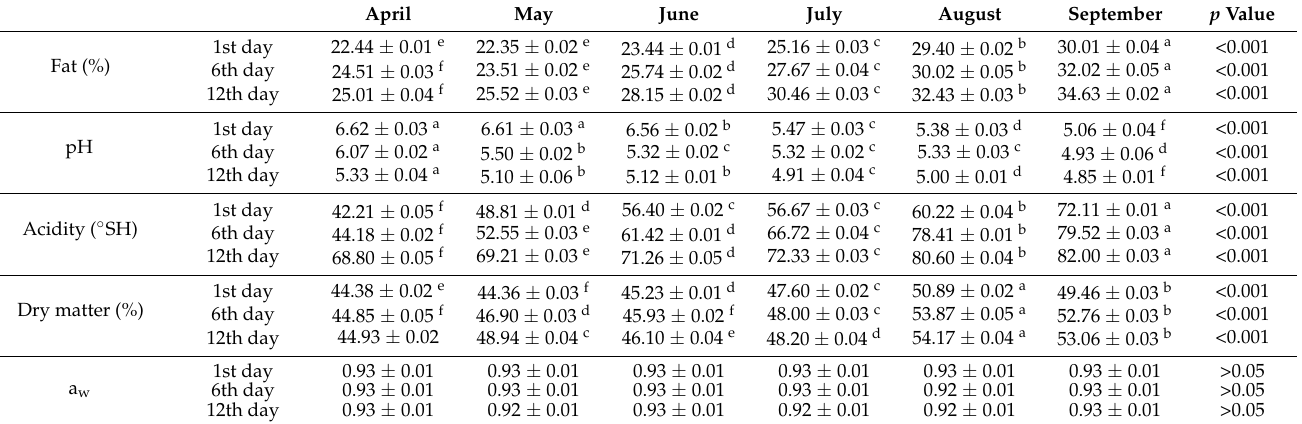
Table 5. Means and their standard deviations (mean ± SD) of the physical and chemical indicators of goat cheese samples at 1st, 6th, and 12th day of ripening.